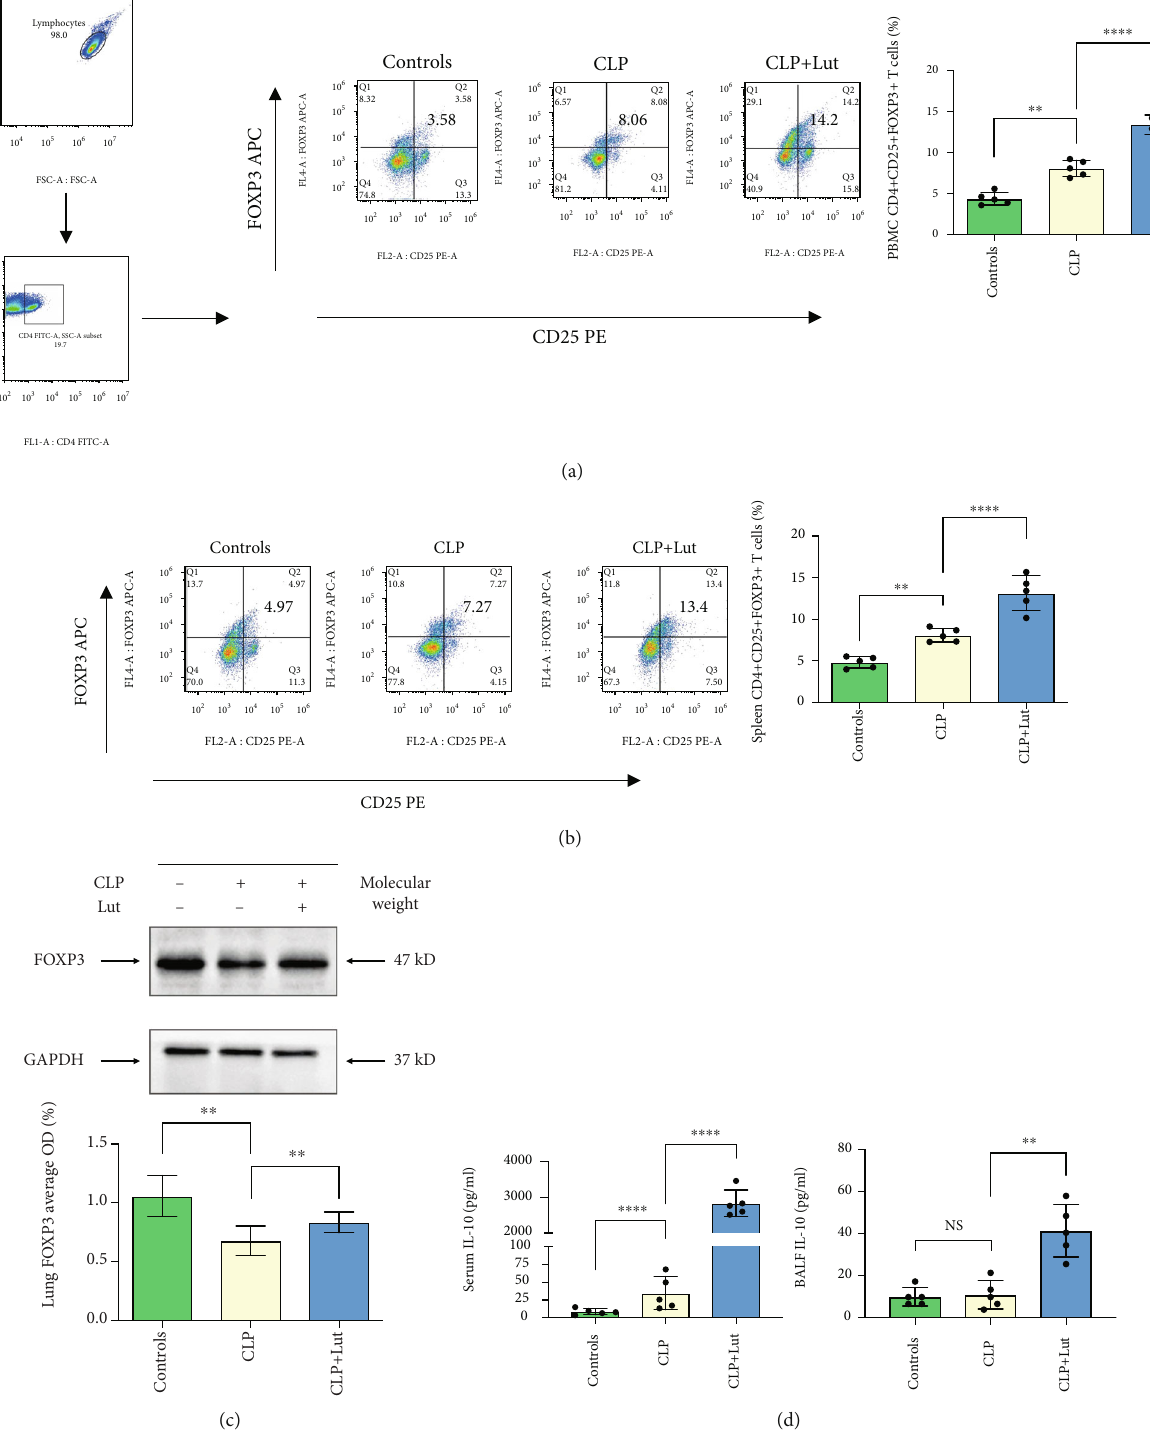
Figure 2: Treatment with luteolin increases the proportion of Tregs and the expression of Foxp3 in the CLP-induced mouse model. (a, b) Treatment with luteolin signi fi cantly increased the proportion of CD4 + CD25 + FOXP3 + Tregs in splenic mononuclear cells and PBMCs of CLP mice. CD4 + CD25 + FOXP3 + Tregs in splenic mononuclear cells and PBMCs were detected by fl ow cytometry. (c) Treatment with luteolin increased the expression of Foxp3 in lungs of CLP mice. Foxp3 protein levels were measured by western blot. (d) Treatment with luteolin promotes the expression of IL-10 in serum and BALF of CLP mice, thereby playing an anti-in fl ammatory role. IL-10 levels in serum and BALF of mice were measured using a mouse cytokine/chemokine magnetic bead panel kit. Each group n = 5 , experiments are repeatable, and the most representative one was shown. Data of the column graphs are presented as means ± SD . NS: not signi fi cant. ∗ p < 0 : 05 , ∗∗ p < 0 : 01 , ∗∗∗ p < 0 : 001 , and ∗∗∗∗ p < 0 : 0001 by the one-way ANOVA followed by LSD multiple comparison test, compared between the control, CLP, and CLP+Lut